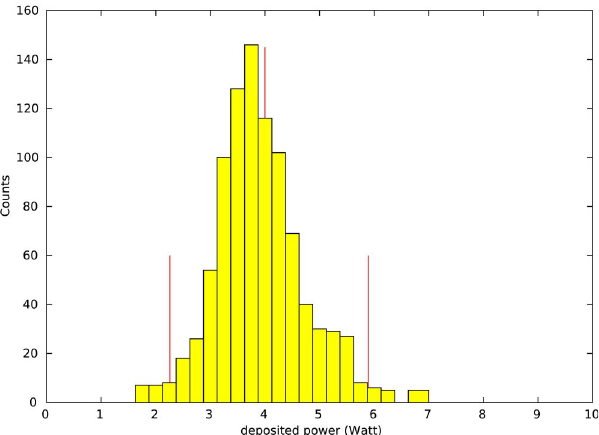
FIG. 23. (Color) Empirical bootstrap distribution for the return level with a probability of 0 : 97 . The two small red marks indicate the (cid:5) 2 (cid:1) interval, the big red mark indicates the return level obtained with a direct estimate from the recorded losses.